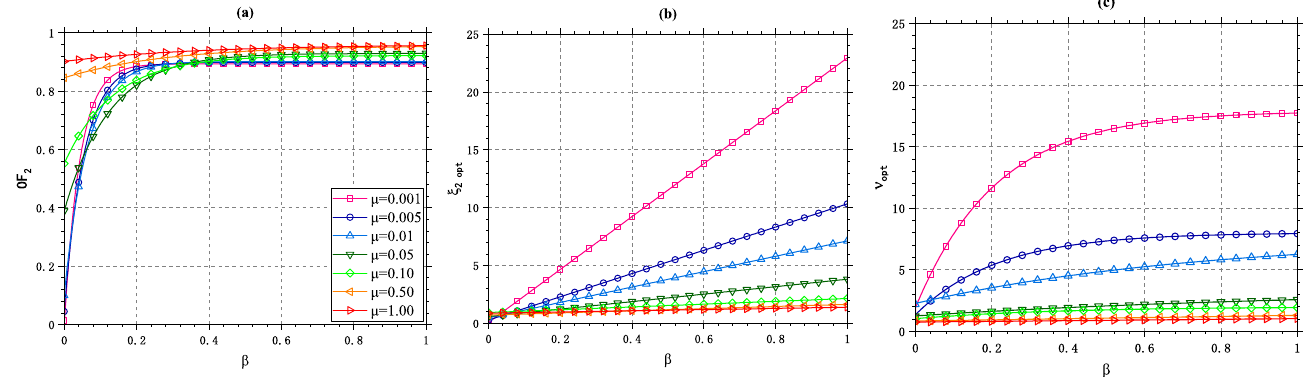
Figure 4. Maximum energy dissipation index EDI max ( a ) and optimized design parameter damping ratio ξ 2 opt ( b ) and frequency ratio ν opt ( c ) for parameters β with different mass ratios µ